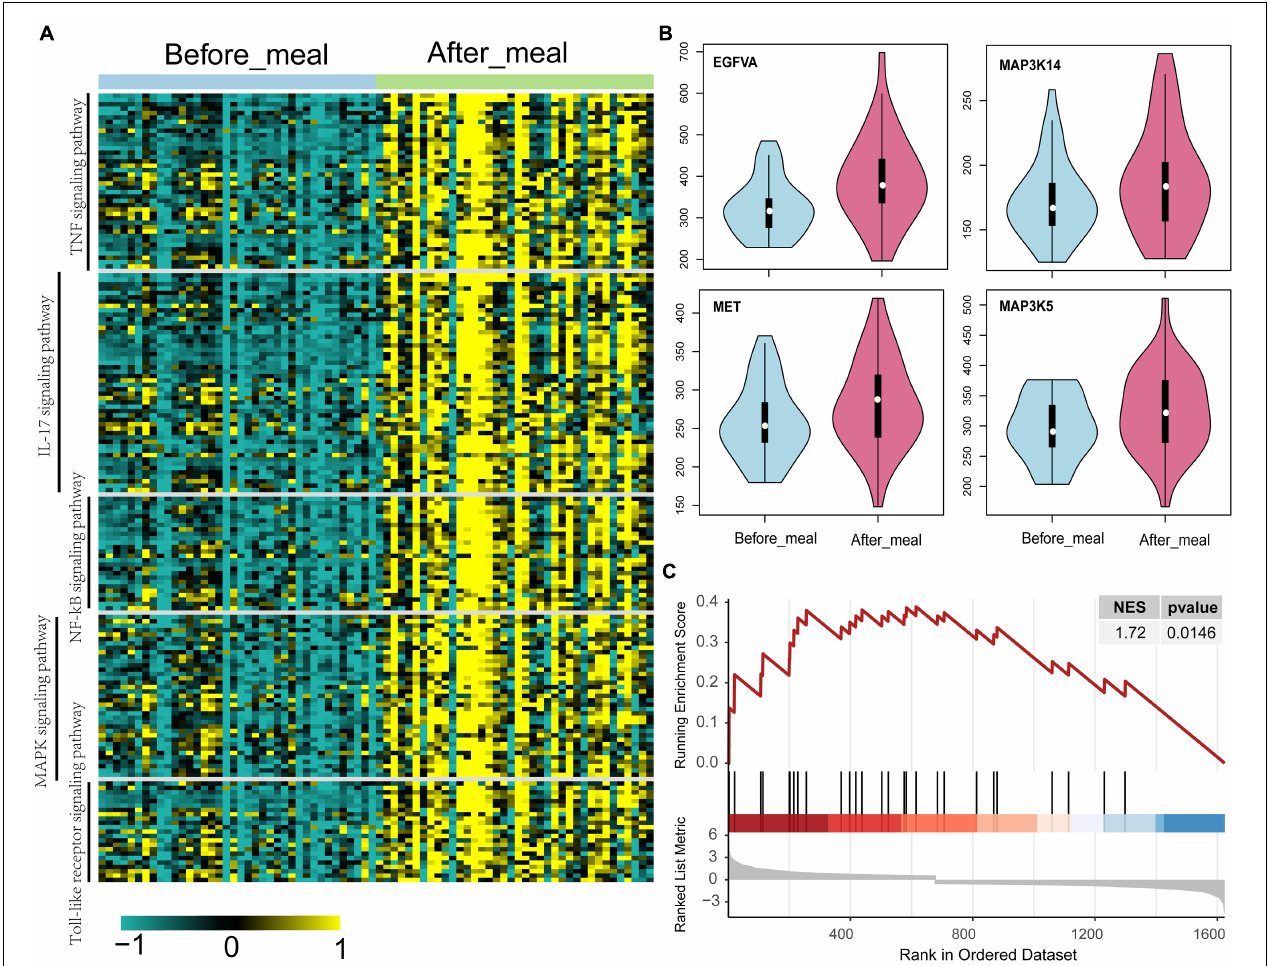
FIGURE 5 | Up-regulated genes and activated KEGG pathways in humans and rats under short- and long-term HFD conditions. (A) KEGG pathways of the significantly differentially expressed genes between adipose tissue under fasting (0 h) and at 4 h post-meal condition. (B) Violin plots show the level of gene expression in adipose tissue under fasting (0 h) and at 4 h post-meal condition. (C) GSEA plot shows the genes upregulated in the adipose tissue of HFD rat are enriched in MAPK signaling